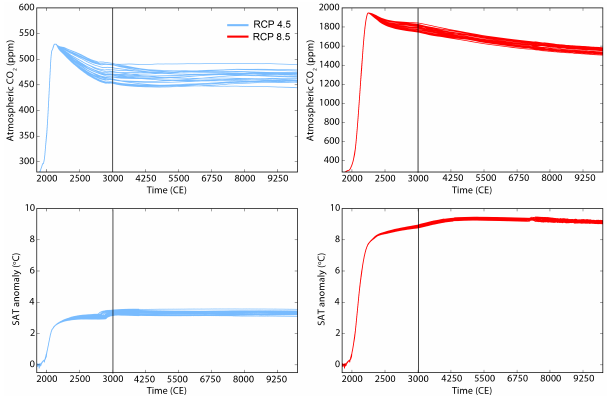
Figure 8. Evolution of CO 2 and surface air temperature (SAT) anomaly under continued RCPs 4.5 and 8.5 forcing until common era year 10000 (8000 years into the future). Vertical black line in- dicates change in horizontal scale.